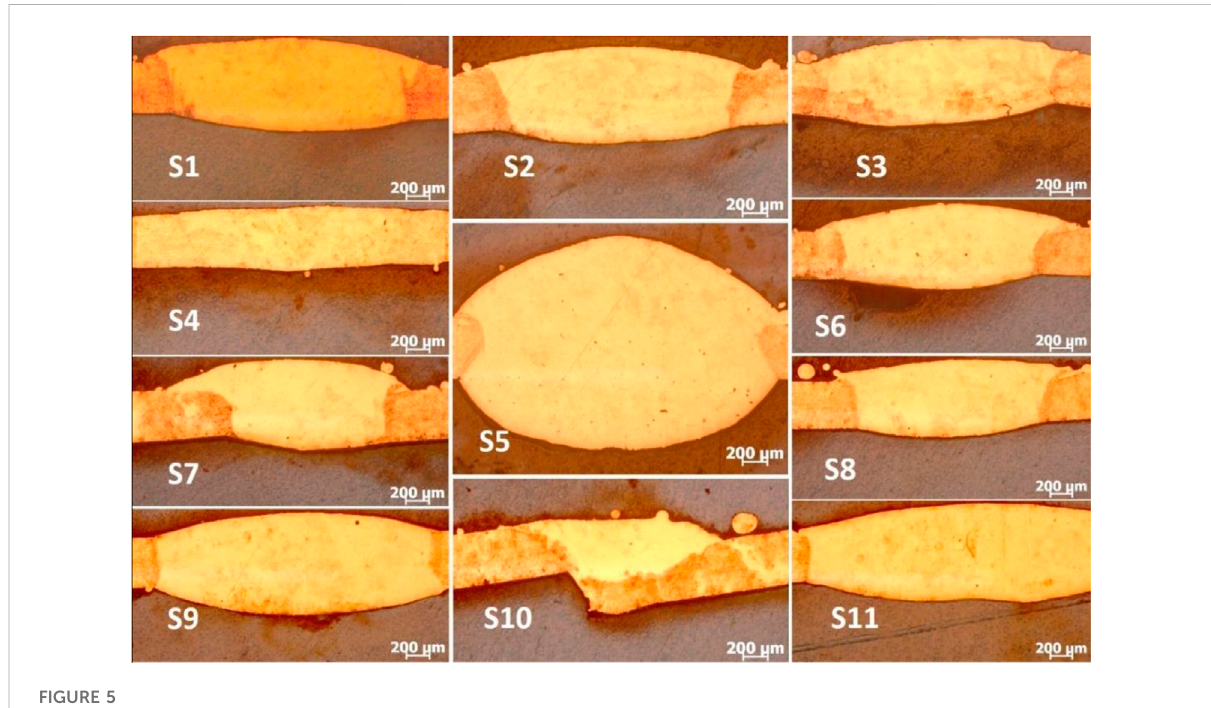
FIGURE 5 Optical microstructure of the samples.